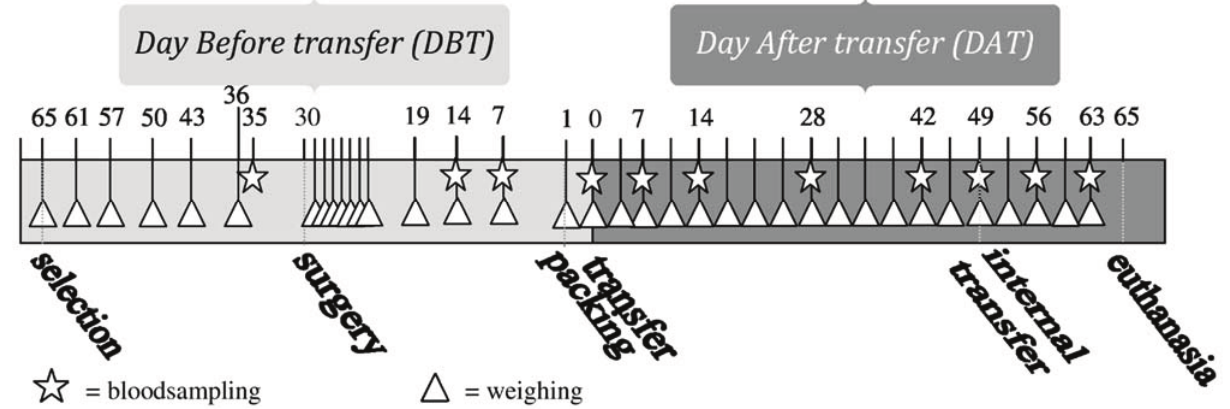
Figure1. Timeline of performed